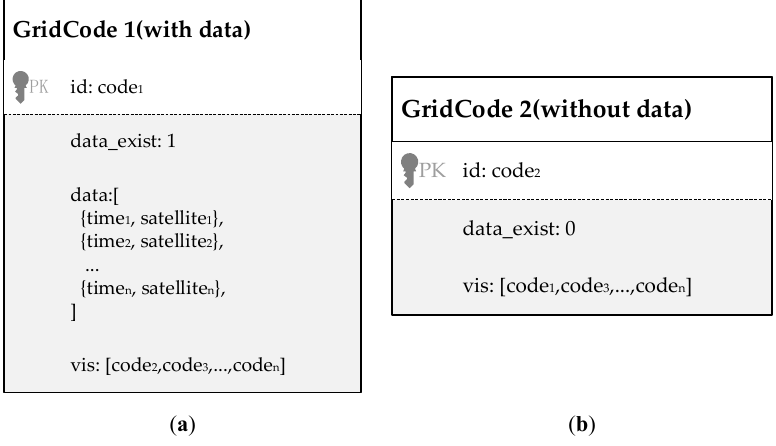
Figure 5. Documents of grid codes: ( a ) with data; ( b ) without data.